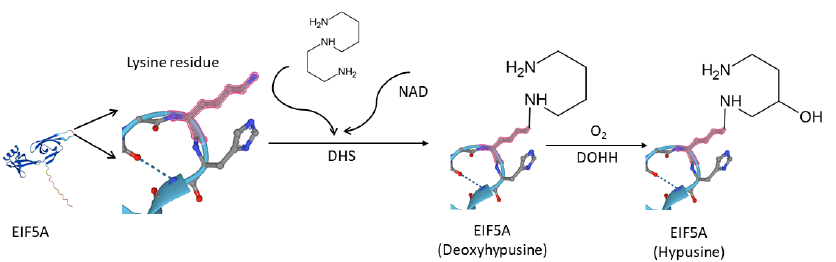
Figure 1. DHS catalyzes the transfer of the 4-aminobutyl moiety of spermidine to a specific lysine residue in the EIF5A precursor protein to form a deoxyhypusine-containing EIF5A intermediate, EIF5A (Deoxyhypusine) [11]. Subsequently, DOHH hydroxylates the aminobutyl portion of the deoxylated hypusine, resulting in the formation of EIF5A (Hypusine) [12].